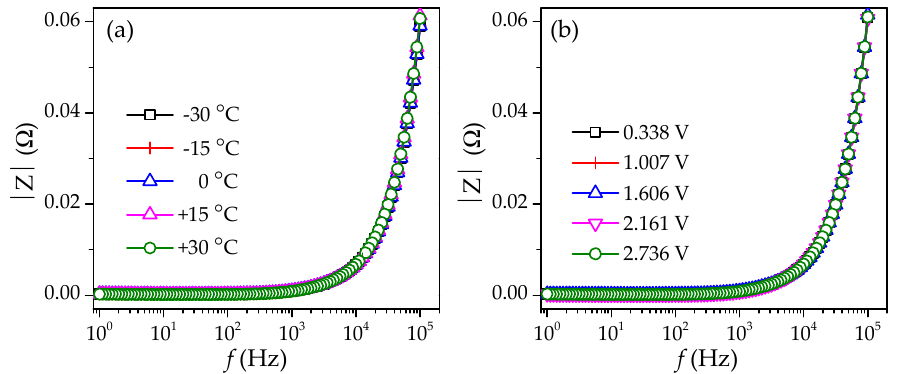
Figure 3. Module impedance (|Z|) as a function of frequency ( a ) at different temperatures for constant voltage (~2.5 V), and ( b ) at different voltages for a constant temperature of 15 °C.